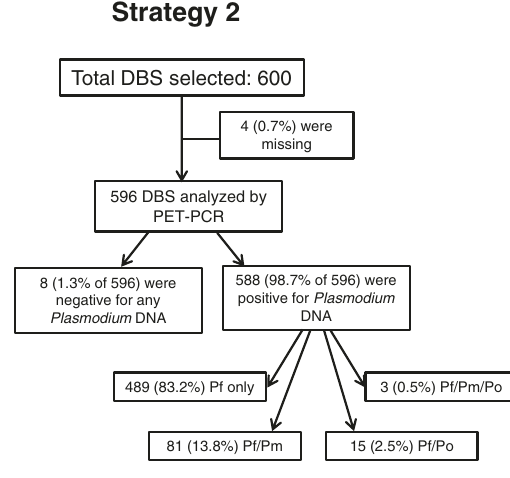
100 samples per Nigerian zone. Terminal boxes display number (and percentage) of each type of infection for samples that were Plasmodium DNA positive. DBS: